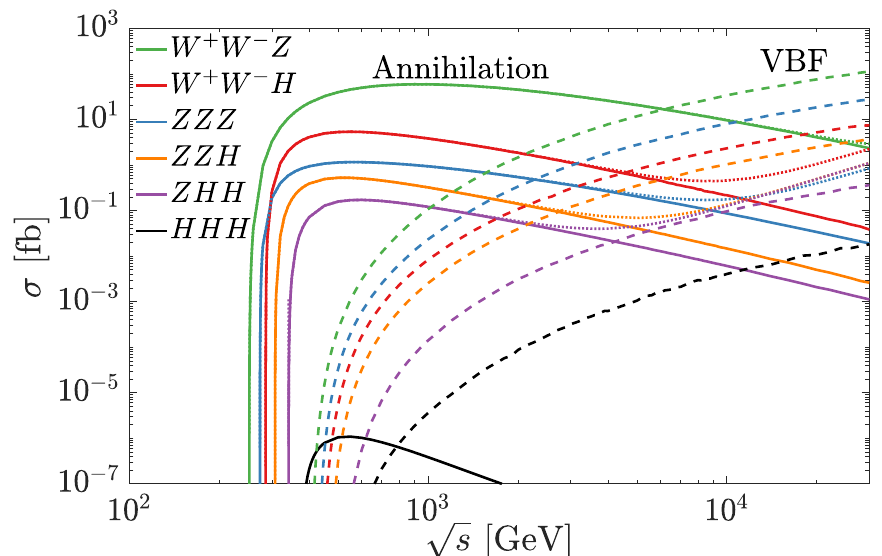
Figure 5 . Similar to figure 4, the cross sections of three-boson production at a µ + µ − collider as a √ function of the c.m. energy s